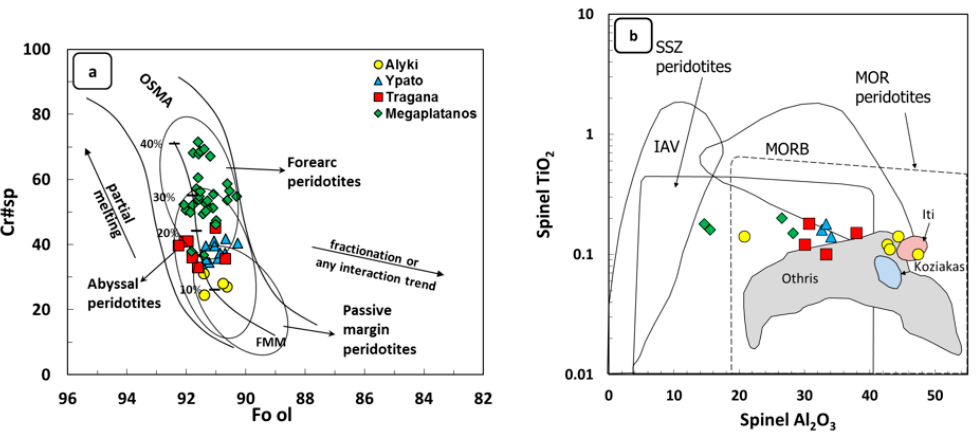
Figure 5. ( a ) Compositional relationship between Fo content of olivine and Cr#s of coexisting Cr- spinels of mantle peridotitic rocks from Lokris and Beotia; the olivine–spinel mantle array (OSMA) is after [2]; ( b ) Binary diagram of TiO 2 (wt. %) vs. Al 2 O 3 (wt. %) contents for spinels from Lokris and Beotia peridotites. Fields for mid-ocean ridge basalts (MORB) and island arc volcanics (IAV), as well as MOR and supra-subduction zone (SSZ) peridotites according to [7]. Field for spinels from Iti, Othris